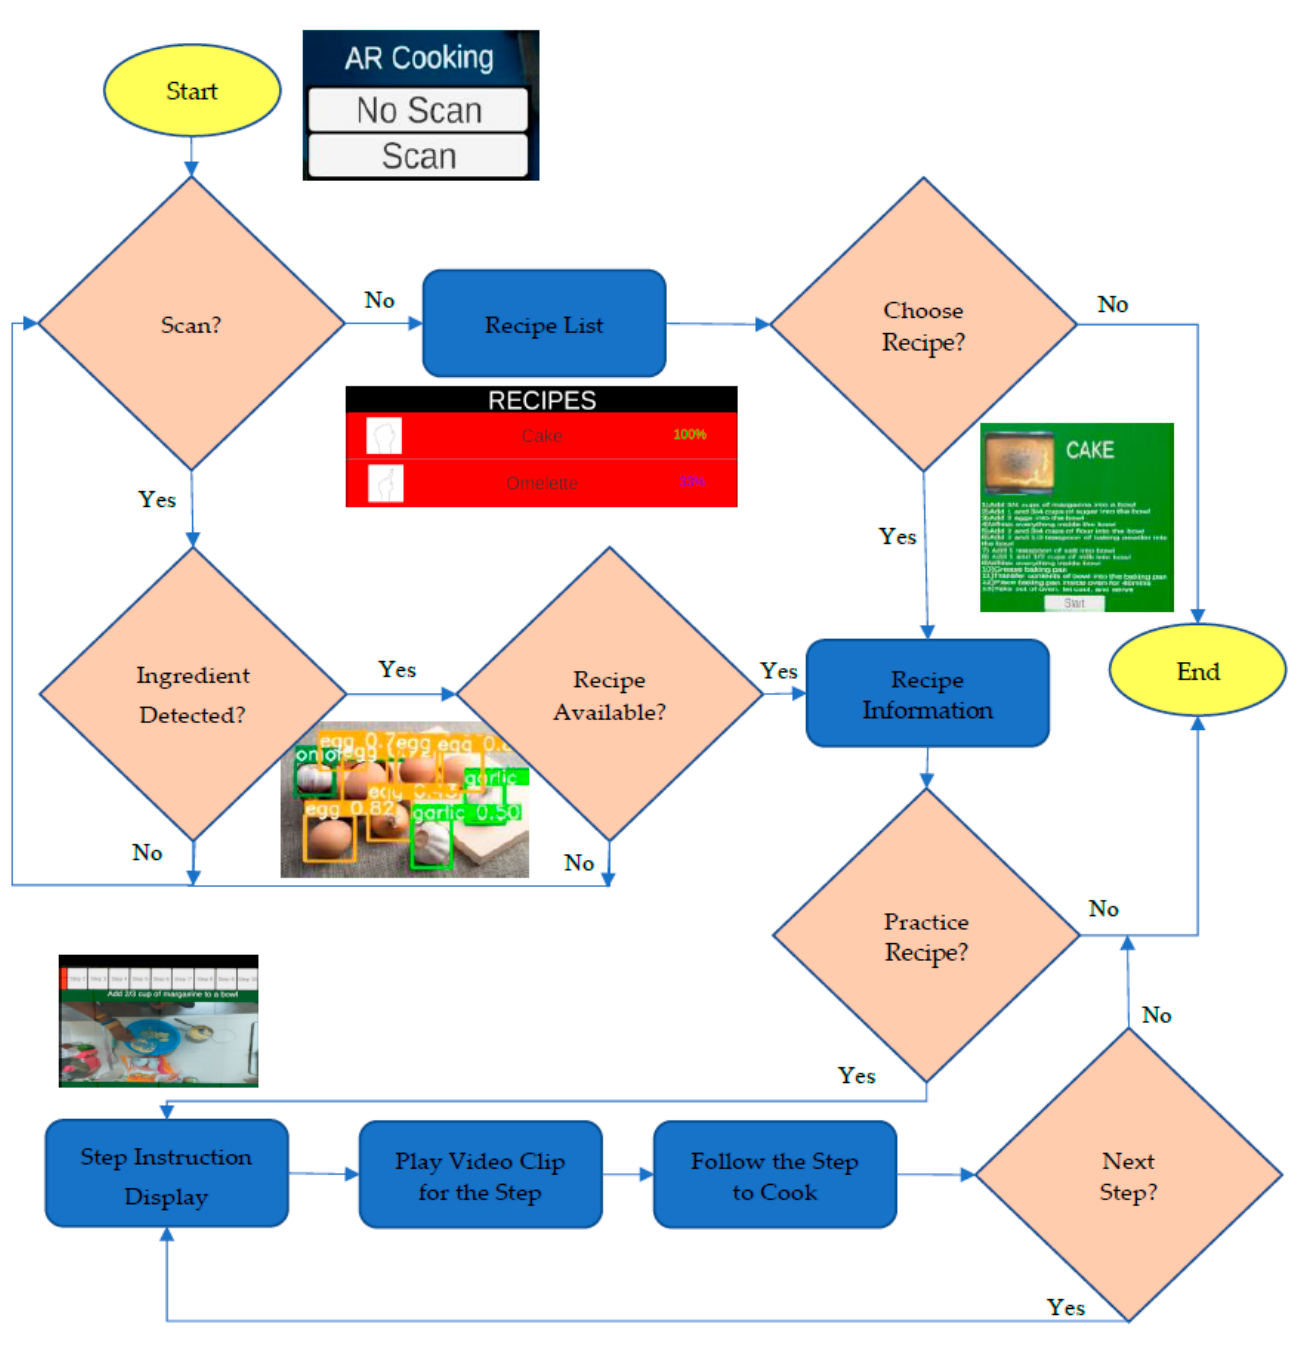
Figure 3 . Flowchart of the proposed AR cooking assistance system . Figure 3. Flowchart of the proposed AR cooking assistance